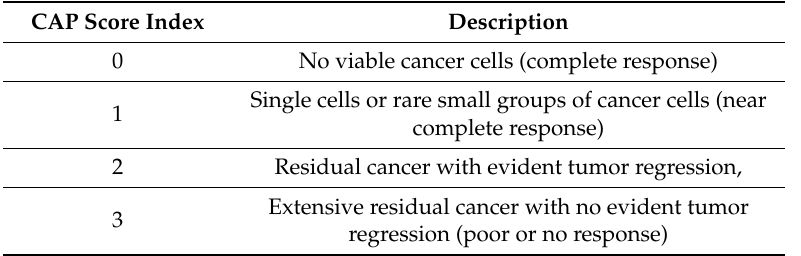
Table 2. Classification of the College of American Pathologists for Treated Pancreatic Ductal Adenocarcinoma (Ryan, Histopathology,